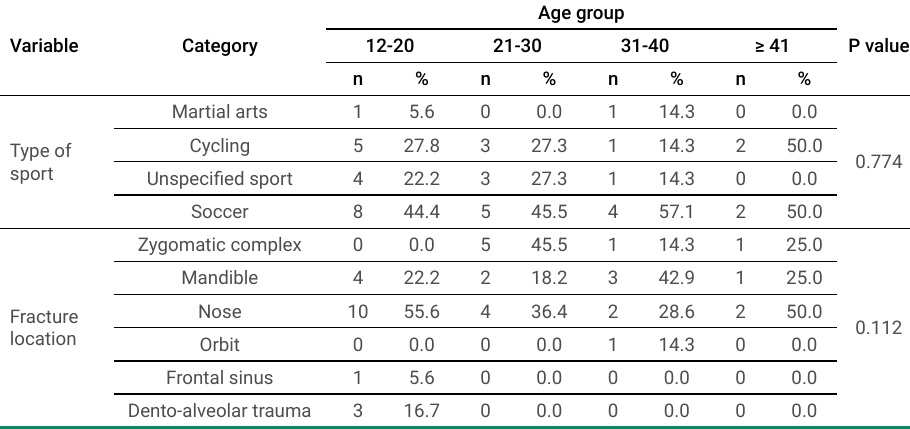
Table 2. Age-specific distribution of patients by type of sport and fracture location according to the likelihood ratio test significance. Variable